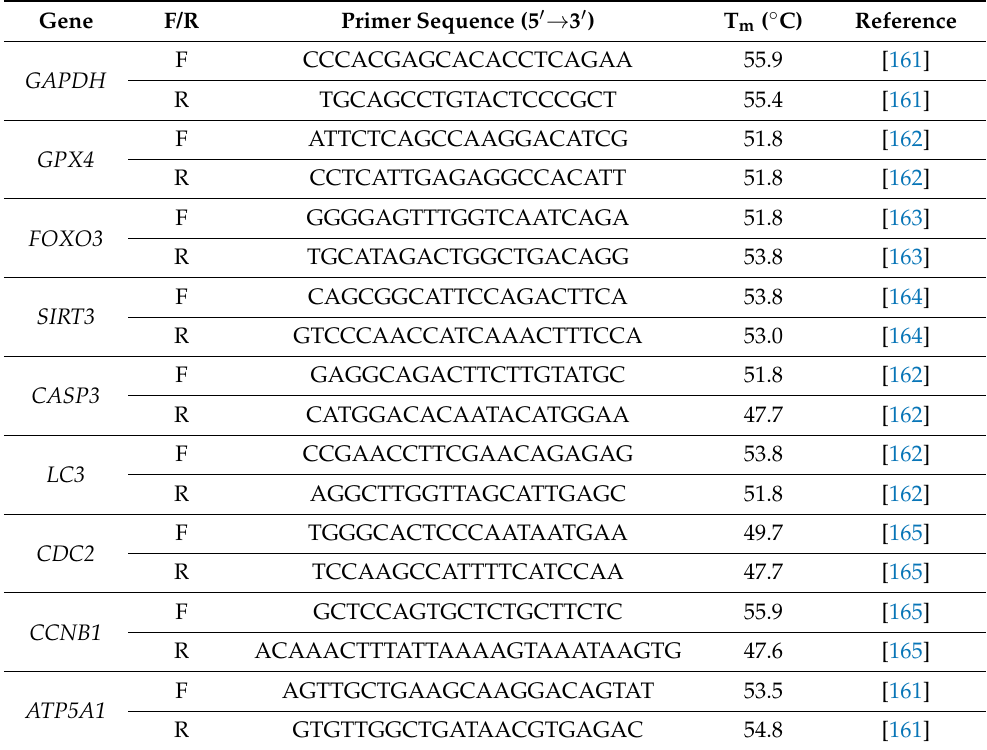
Table 1. Primers used for